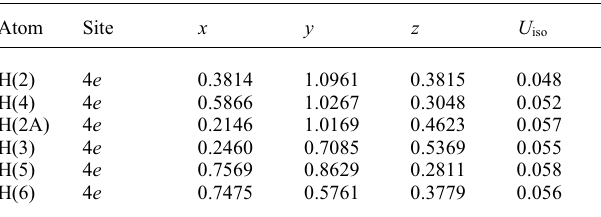
Table 2. Atomic coordinates and displacement parameters (in Å 2 )